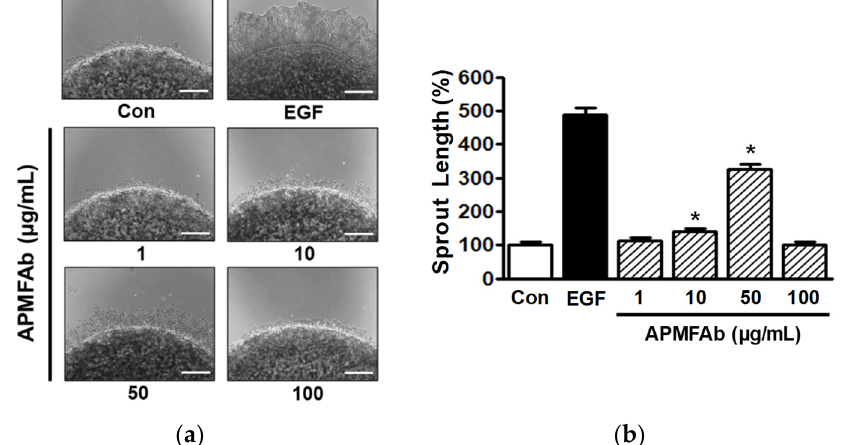
Figure 2. Effect of Angelica polymorpha Maxim. flower absolute on sprout formation by HaCaT cells. ( a ) HaCaT cells were mixed with collagen and spotted on 24-well plate. Spots were incubated with or without Angelica polymorpha Maxim. flower absolute (APMFAb) (1–100 μ g/mL) for 48 h. Spots and sprouts were then stained with Diff-Quick solution and images were acquired using a microscope. Epidermal growth factor (EGF) (50 ng/mL) was used as the positive control. Scale bar = 100 µ m. ( b ) Statistical graph obtained from panel A. Results are presented as mean percentages ± SEMs of non-treated controls (Con) ( n = 3). * p < 0.05 vs. non-treated controls.